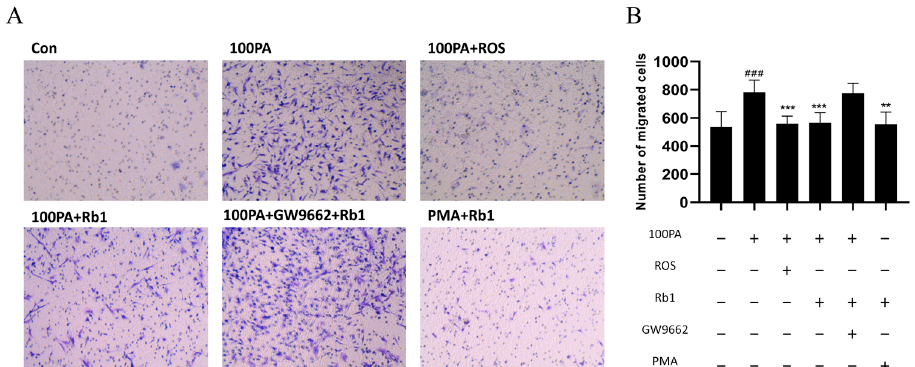
Figure 7. PM cells were co-cultured in the Transwell chamber and Rb1 affected the migration efficiency. ( A ) The analysis of cell migration number of view after crystal violet staining (20 × ) and their quantification diagram ( B ). Con: control group; model: mature adipocyte supernatant was incubated with 100 µ M palmitic acid. ### p < 0.001 significantly compared with Con group; *** p < 0.001 significantly compared with model group; ** p < 0.01 significantly compared with model group.